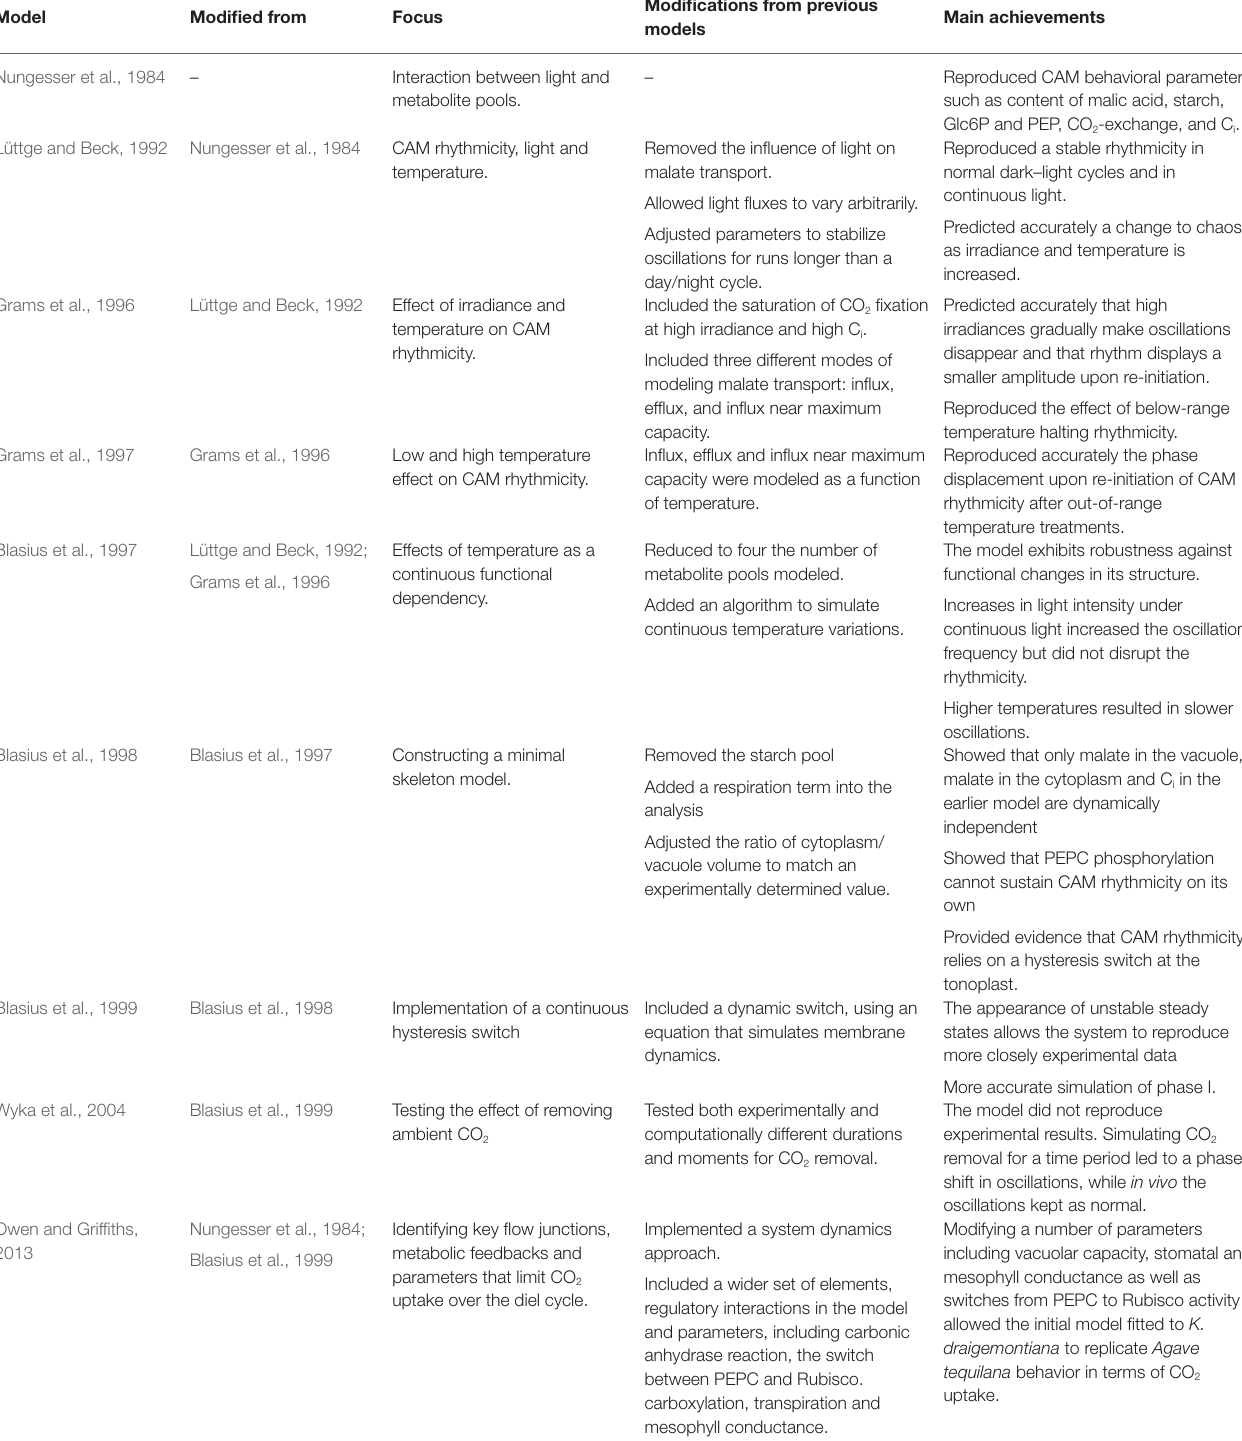
TABLE 1 | Distinctive features of ODE-based models addressing CAM diel